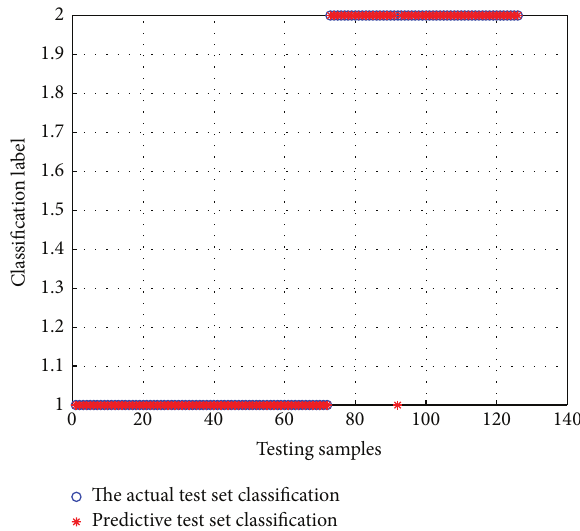
Figure 4: The fitness curve of searching for the best parameters by the PSO method.